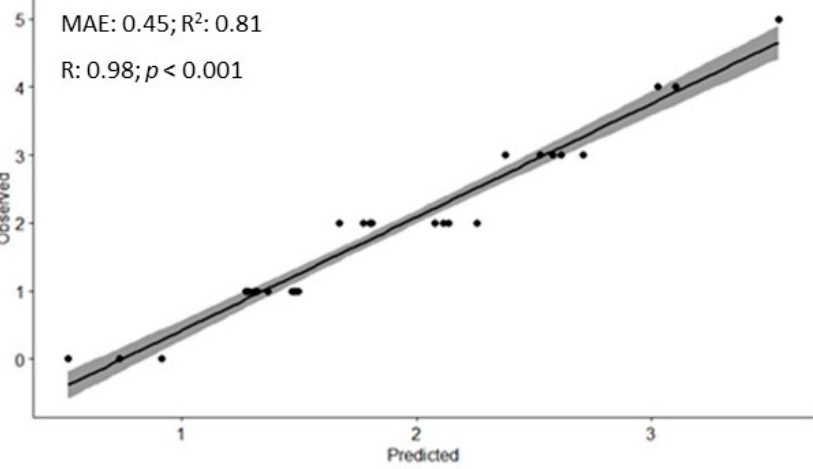
Figure 3. Validation of the random forest model for predicting road crash. Legend: MAE: Mean Absolute Error; R 2 : Coefficient of Determination; R: Correlation Coefficient.